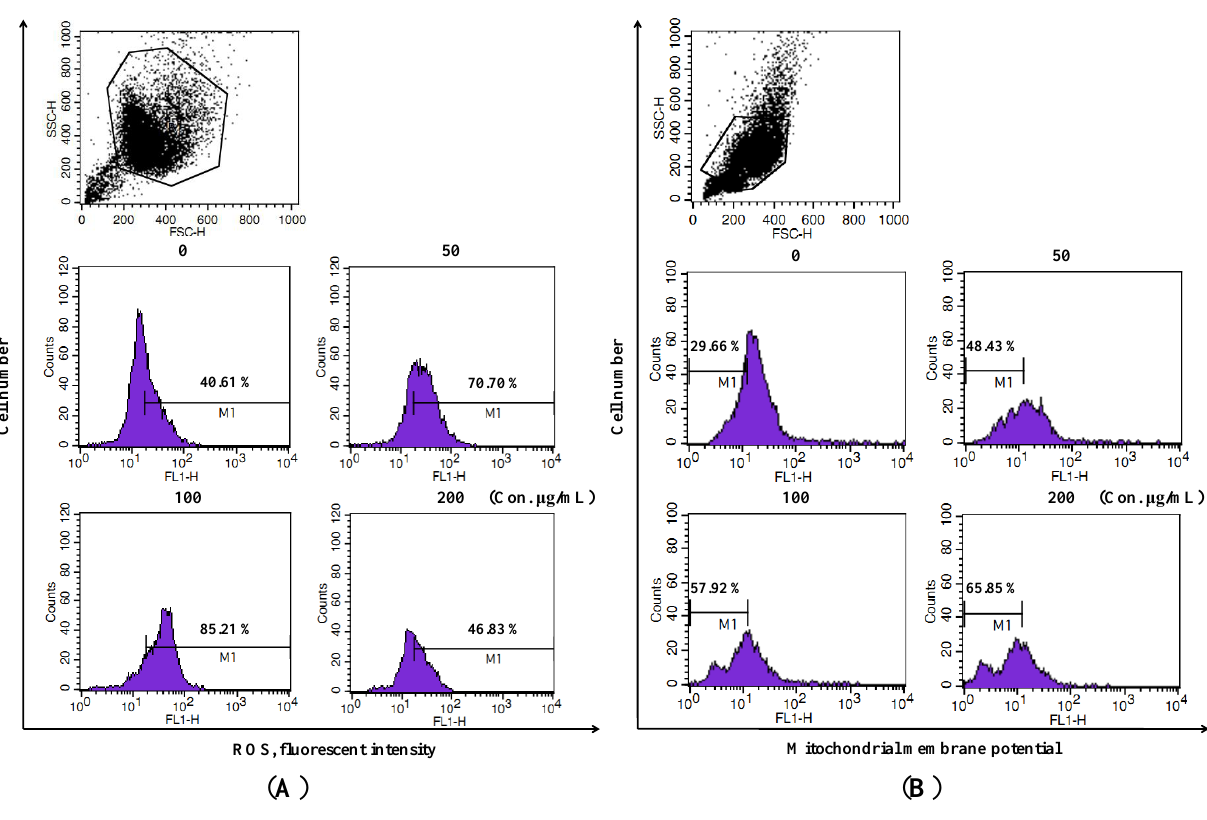
Figure 3. Effect of L. echinata on ROS and MMP levels in HT-29 cells. ( A ) Cells treated with different concentrations of L. echinata for 24 h and the ROS level analyzed by flow cytometry after staining with DCFH-DA; ( B ) The MMP level of the incubated cells were analyzed by flow cytometry after staining with DiOC . 6